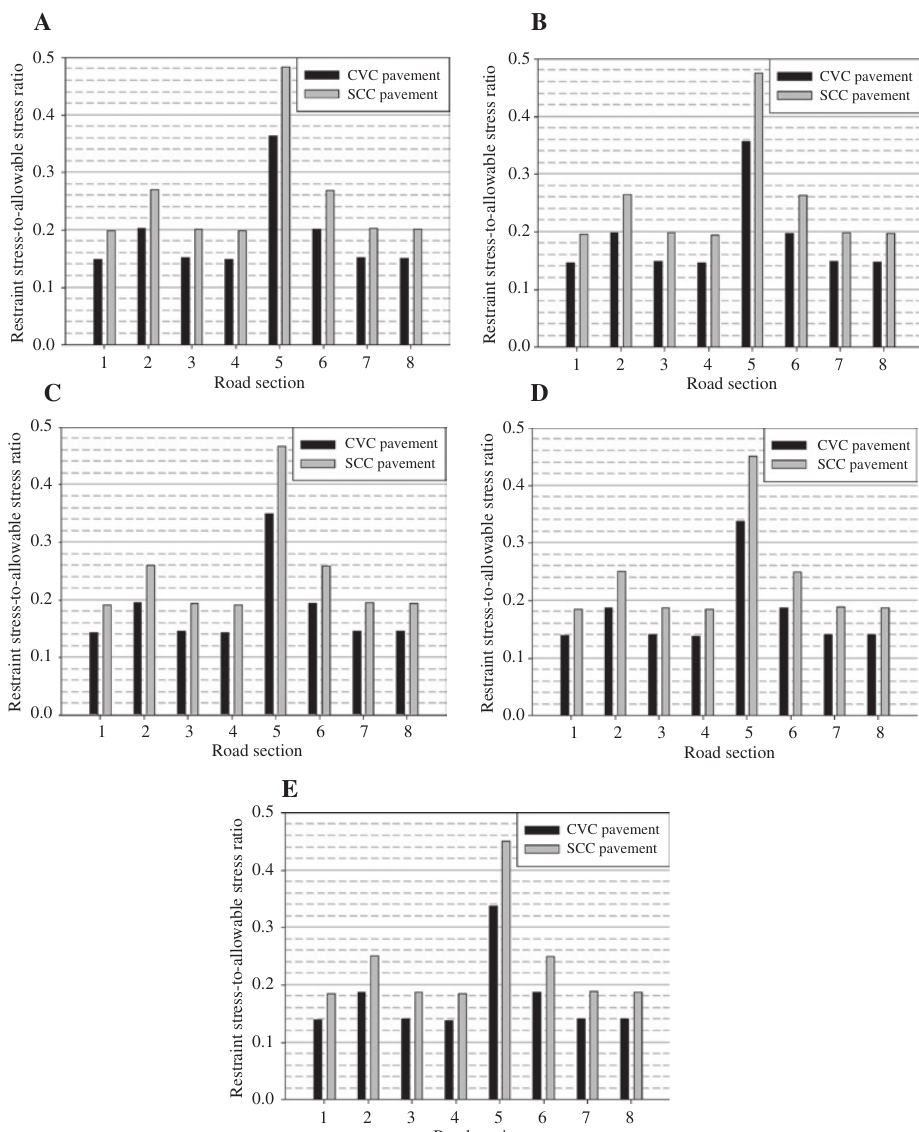
Figure 4: Restraint-to-allowable stress ratios of the CRCP sections in the presence of M19 bars. (A) Grade 10 concrete. (B) Grade 20 concrete. (C) Grade 30 and 40 concrete. (D) Grade 50 concrete. (E) Grade 60